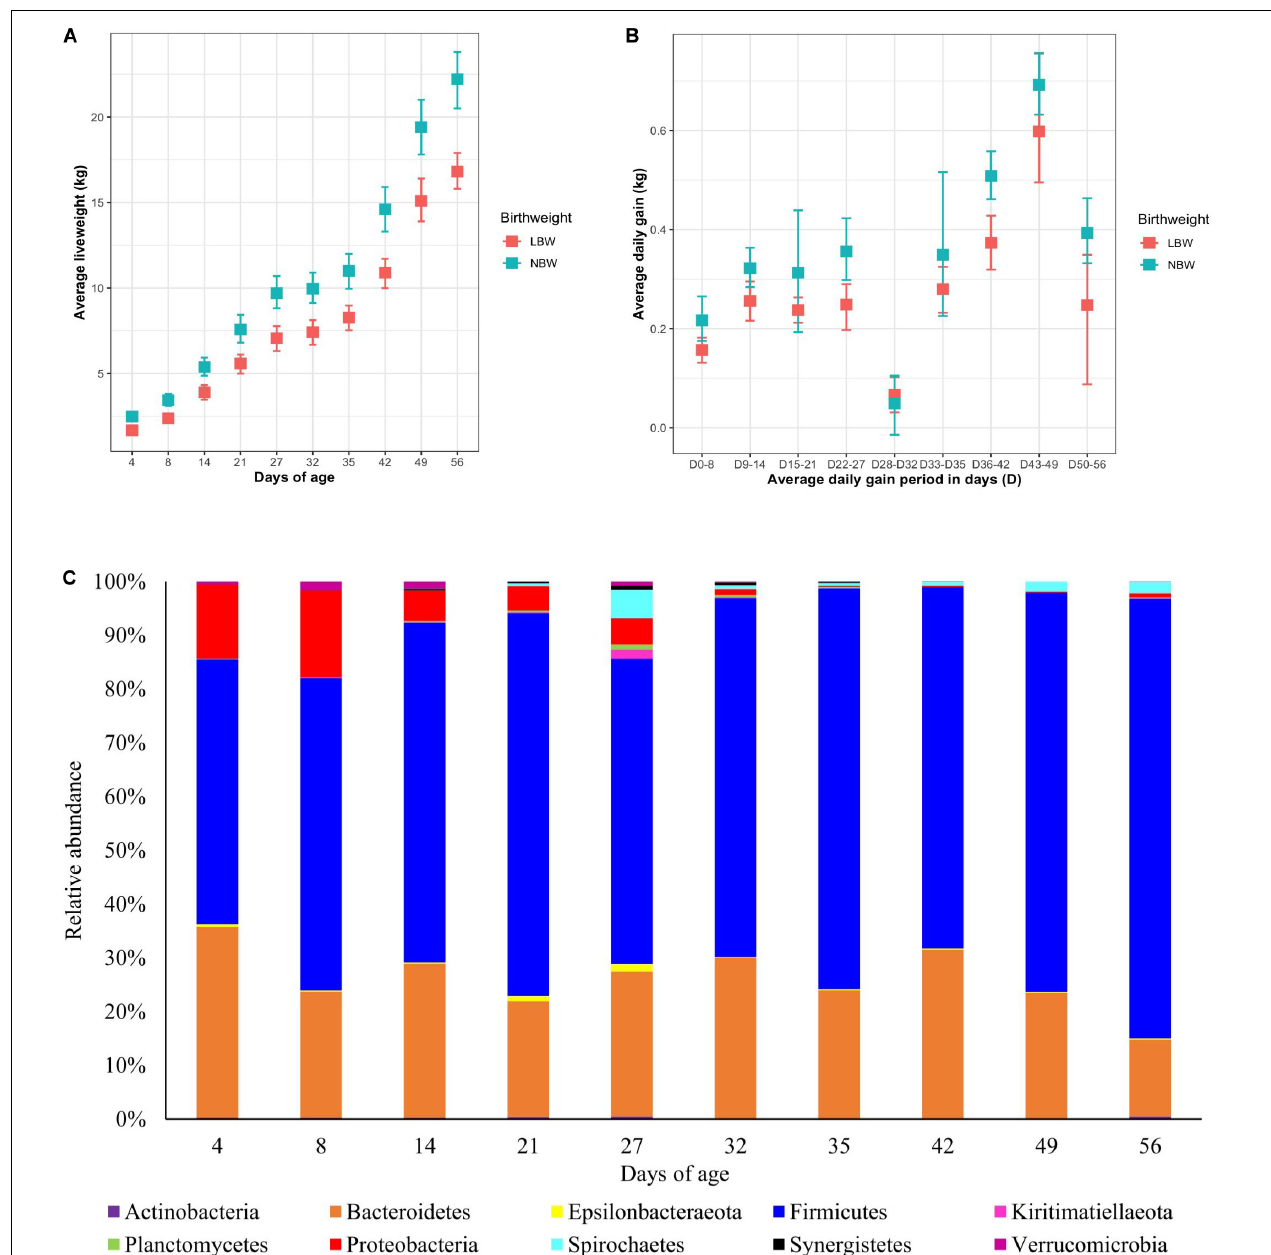
FIGURE 1 | The effect of age on (A) mean liveweight and (B) average daily gain of low birthweight (LBW) and normal birthweight (NBW) pigs, with upper and lower 95% confidence intervals and on (C) the mean relative abundance of the 10 most abundant phyla in the faecal microbiota. Relative abundances has been rescaled to account for only the 10 most abundant